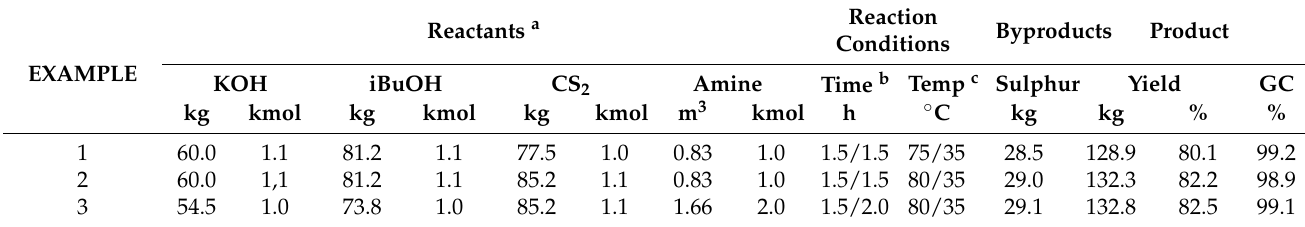
Table 3. The results of the semi-industrial synthesis of N -ethyl- O -isobutyl thiocarbamate. Reactants a